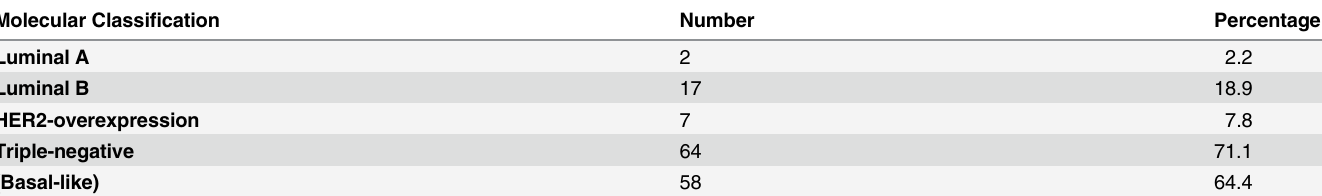
Table 4. Molecular classification of MBC based upon the major component.